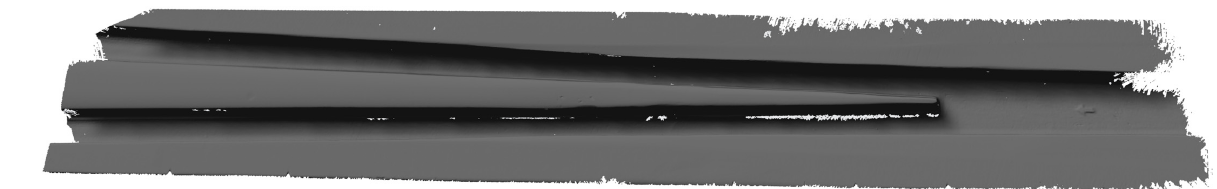
Figure 3. Example of raw 3D geometry scan, crossing panel VAD 131.